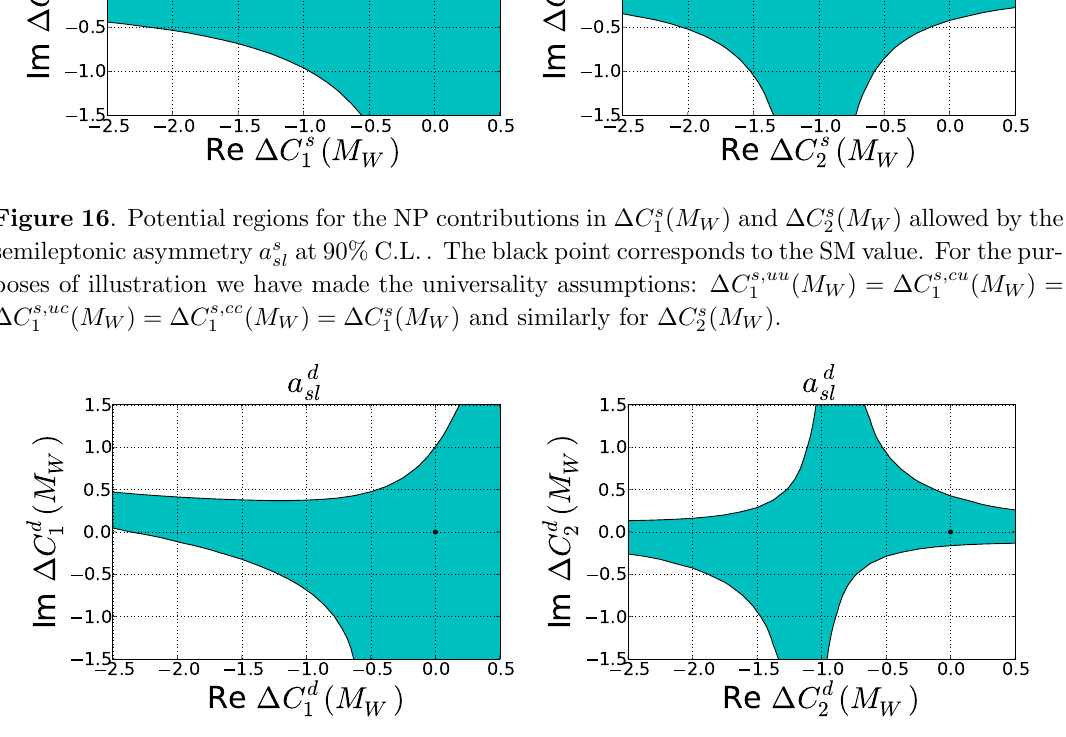
( M W ) and (cid:1) C d ( M W ) allowed by the 1 2